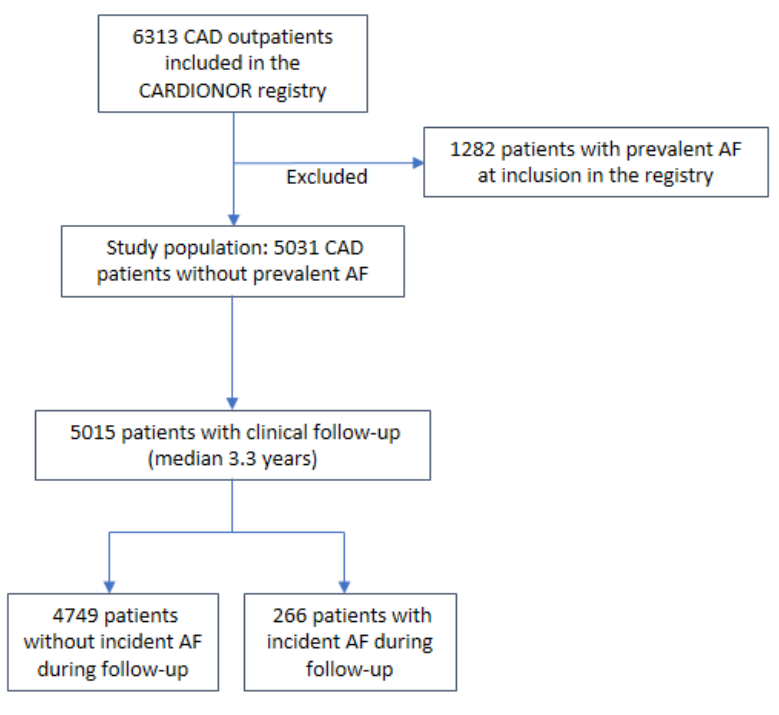
Figure 1. Study flow chart.